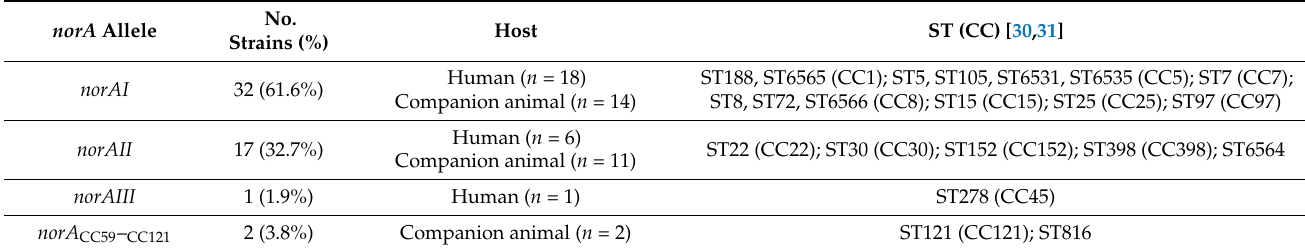
Table 3. Prevalence of the different norA alleles and correlation with S. aureus strain lineages.